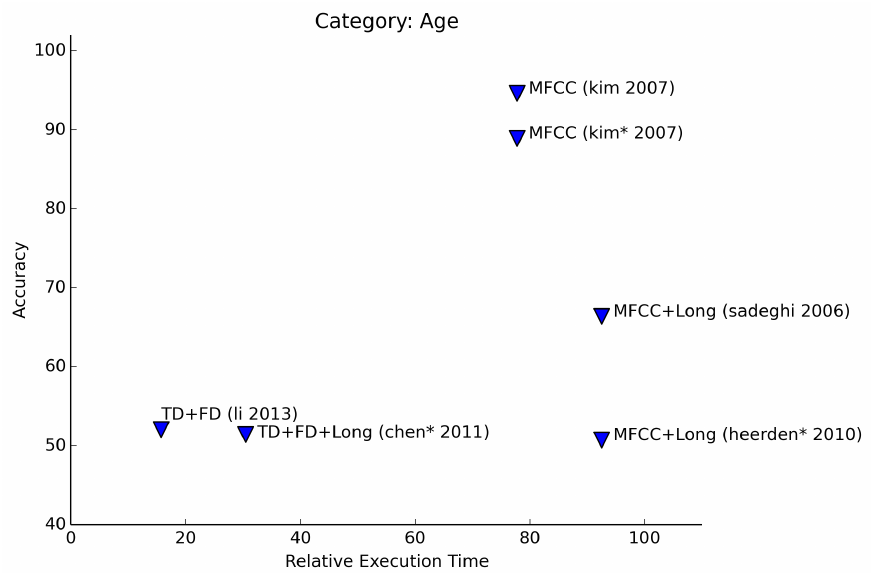
Figure 8. Relative execution time for age